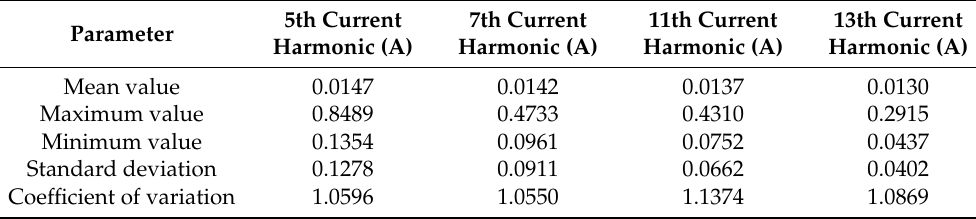
Table 3. Statistical parameters of the 5th, 7th, 11th, and 13th current harmonics from 2018.